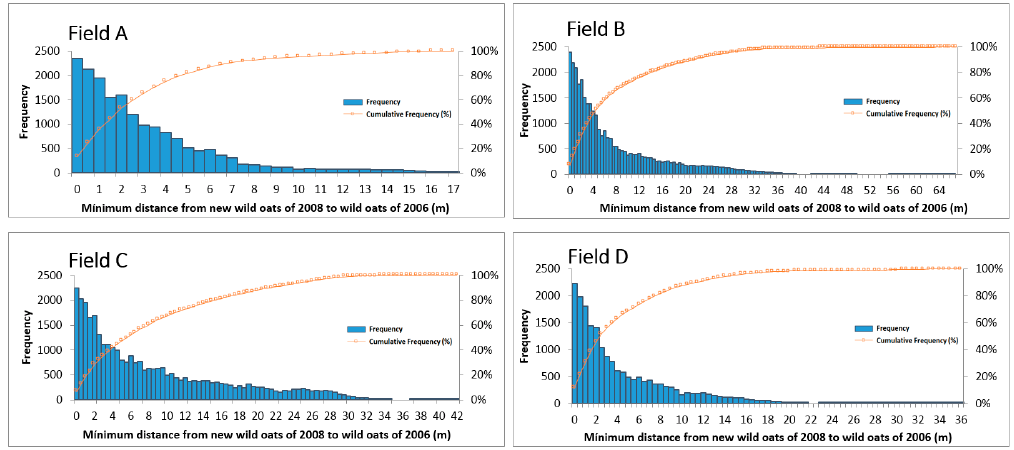
Figure 3. Spreading distance of the four wheat fields by frequency histograms.